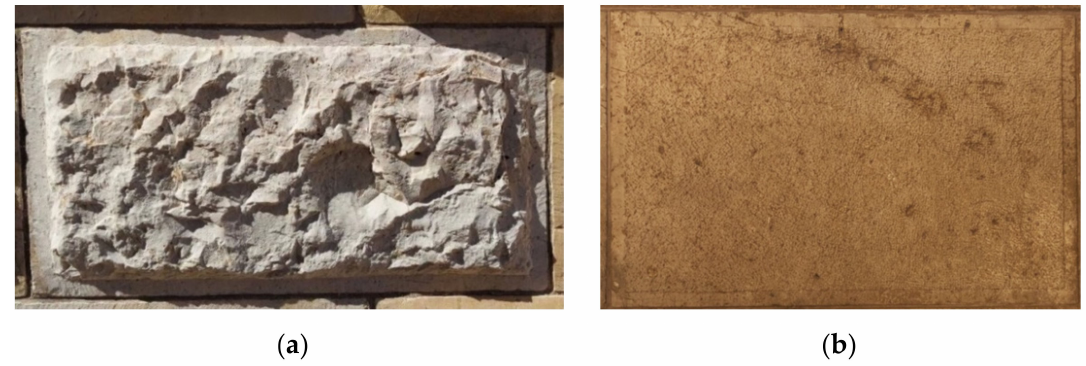
Figure 4. View of polished ( a ) and unpolished ( b ) single-cut white